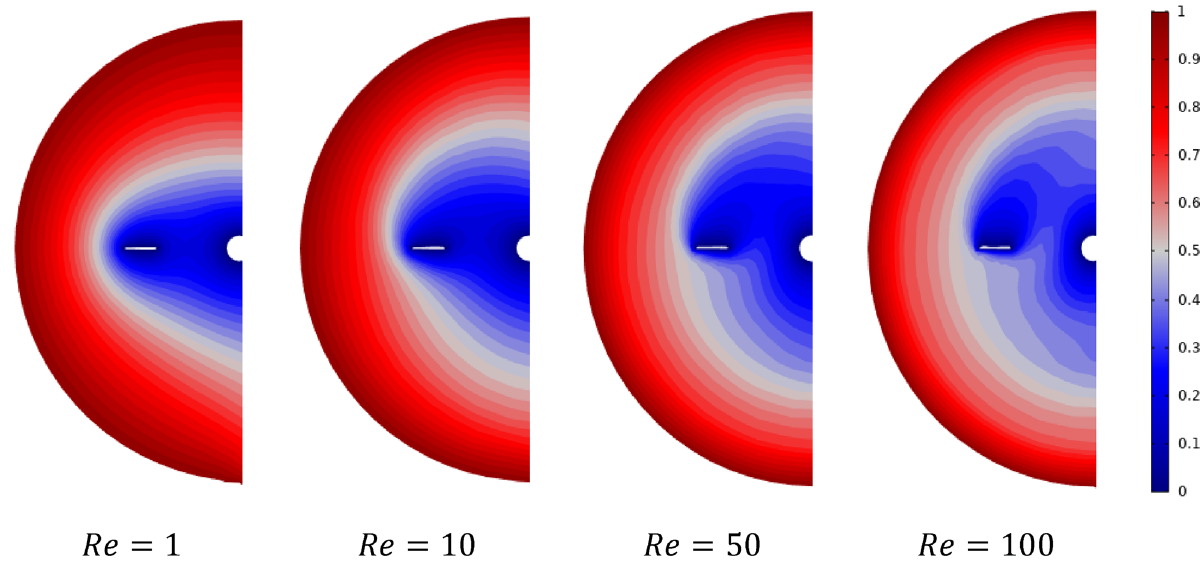
Figure 13. Contour velocity distribution in the horizontal impeller section on the stirred tank for different Reynolds numbers.